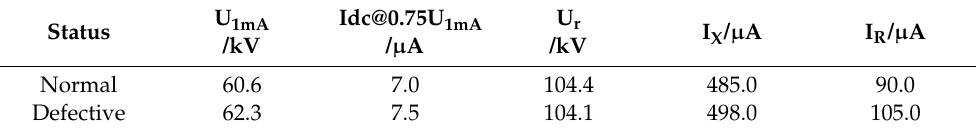
Table 1. Factory performance parameters of a roof